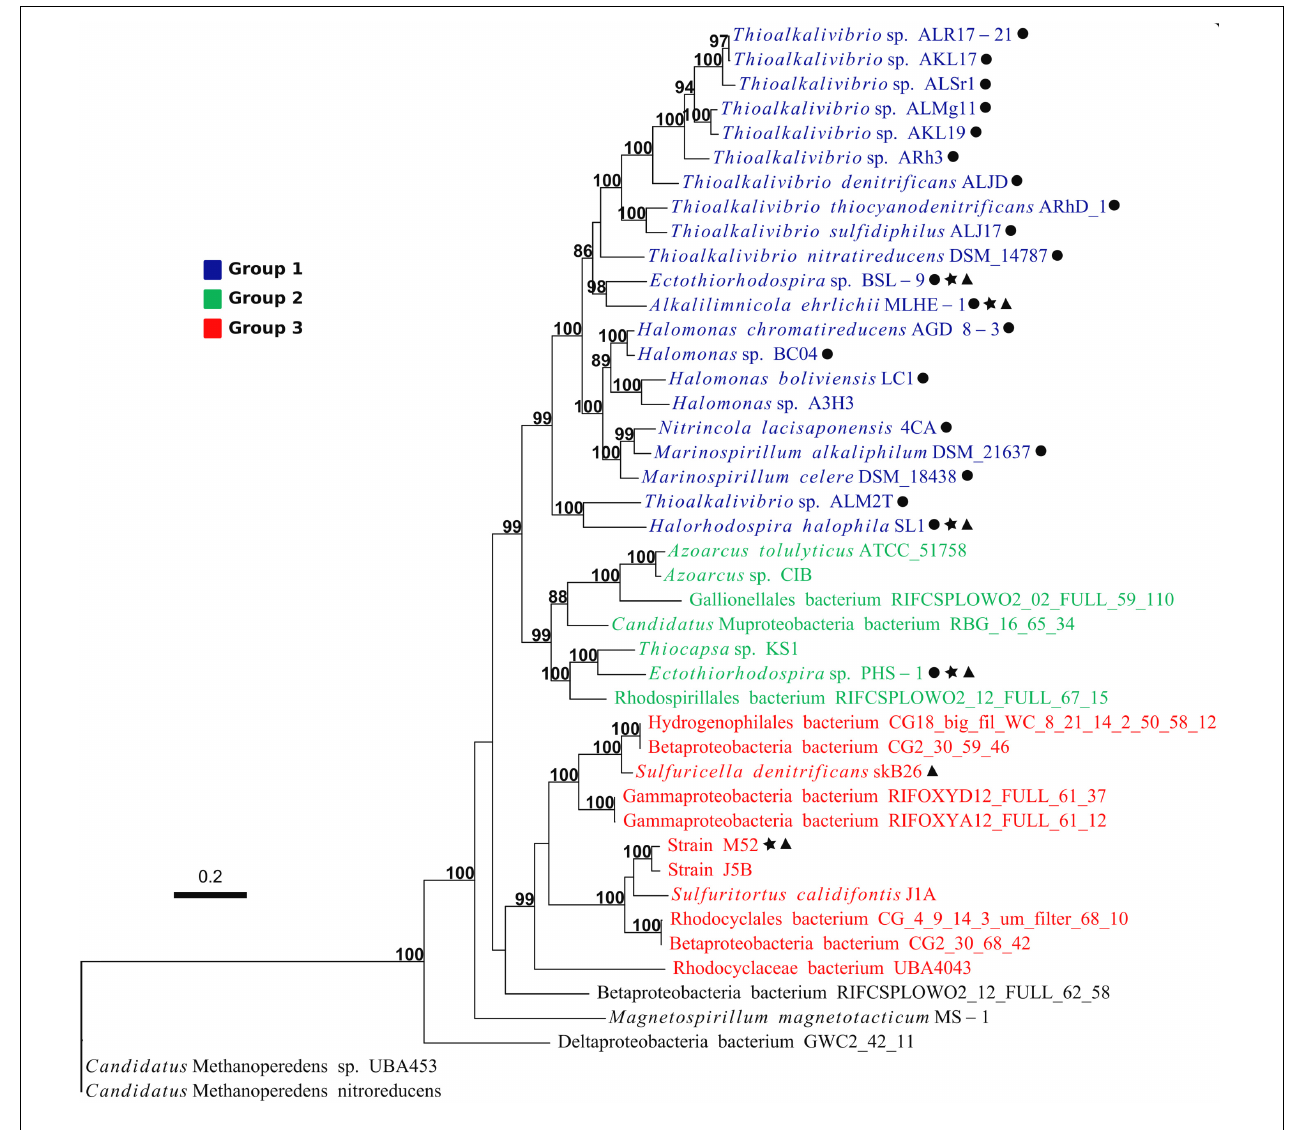
FIGURE 6 | Phylogeny and grouping of ARX based on ArxAB sequences. Support values above 70 are shown. Names with: black circle, represent organisms isolated from high pH/high salinity environments; black star, represent arsenite-oxidizing bacteria; black triangle, correspond to organisms reported to hold an arx operon in the genome. Name of organisms with ARX of group 1, group 2, and group 3 are shown in blue, green and red respectively.